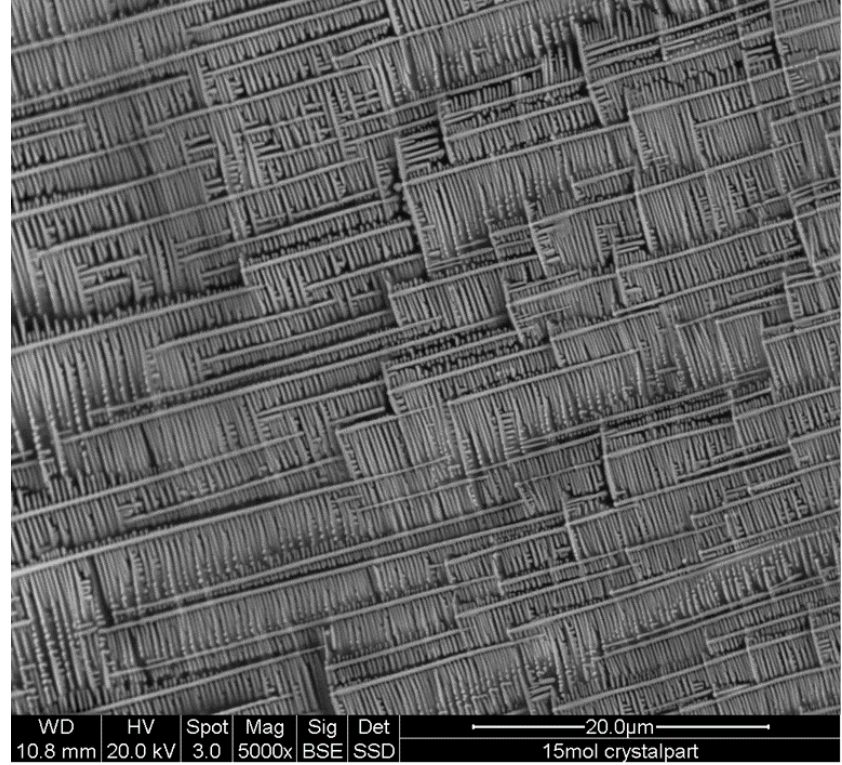
Figure 2. SEM image of the crystal part of 85 (33CaO-67B 2 O 3 ) – 15 Ca 3 WO 6